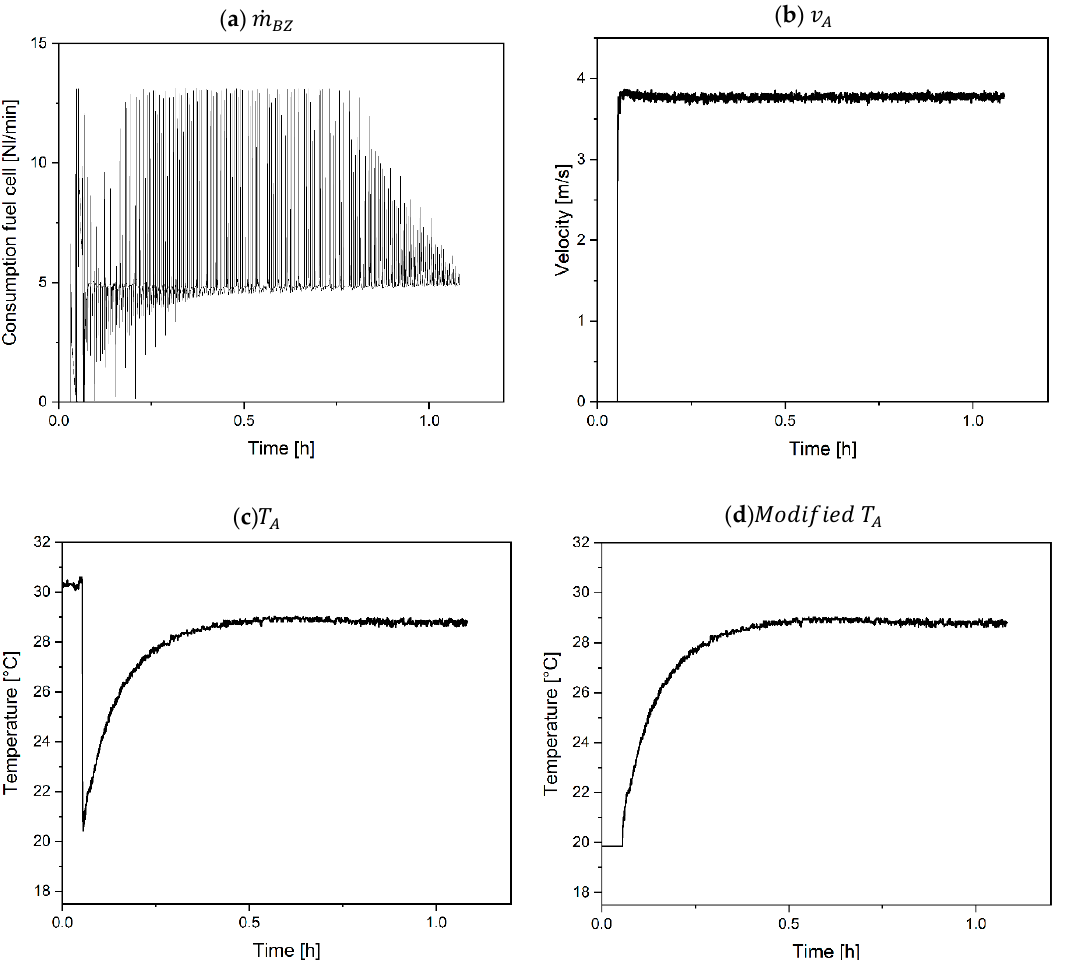
Figure 6. Experimental measurements to set the boundary conditions for the hydride storage and gas network models: ( a ) Fuel cell consumption, ( b ) Air velocity of the exhaust gas from the fuel cell, ( c ) Air temperature, and ( d ) Modified air temperature of the airflow coming from the fuel cell.